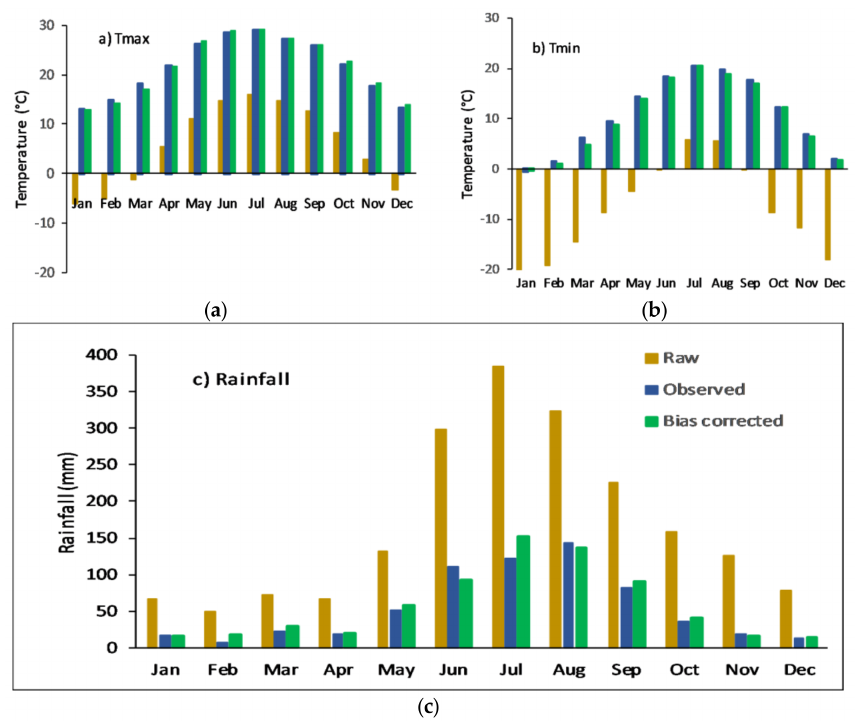
Figure 3. Observed and bias corrected value of ( a ) T max ; ( b ) T min ; and ( c ) rainfall at the Dunai Station of Bheri River